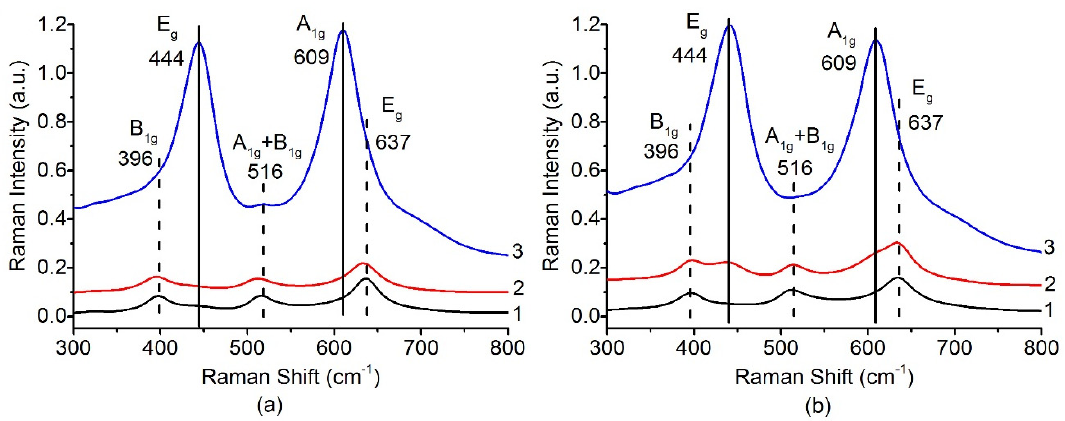
Figure 4. Raman spectra in range 300–800 cm − 1 for ( a ) Pt / Ti-PLA and ( b ) Pt / Ti-P25 catalysts calcined at 400 ◦ C (1), 600 ◦ C (2) and 800 ◦ C (3). Table 2. Results of extended X-ray absorption fine structure (EXAFS) fitting to a structural model containing O backscatterers (first shell) and Ti backscatterers (second shell) as nearest neighbors.